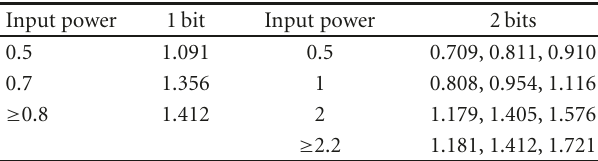
Table 7: Optimal quantization boundaries, unreliable quantization region detection, long-term power constraint, and CG distribution: Nakagami, μ = 2, w = 1, Pe = 0 .